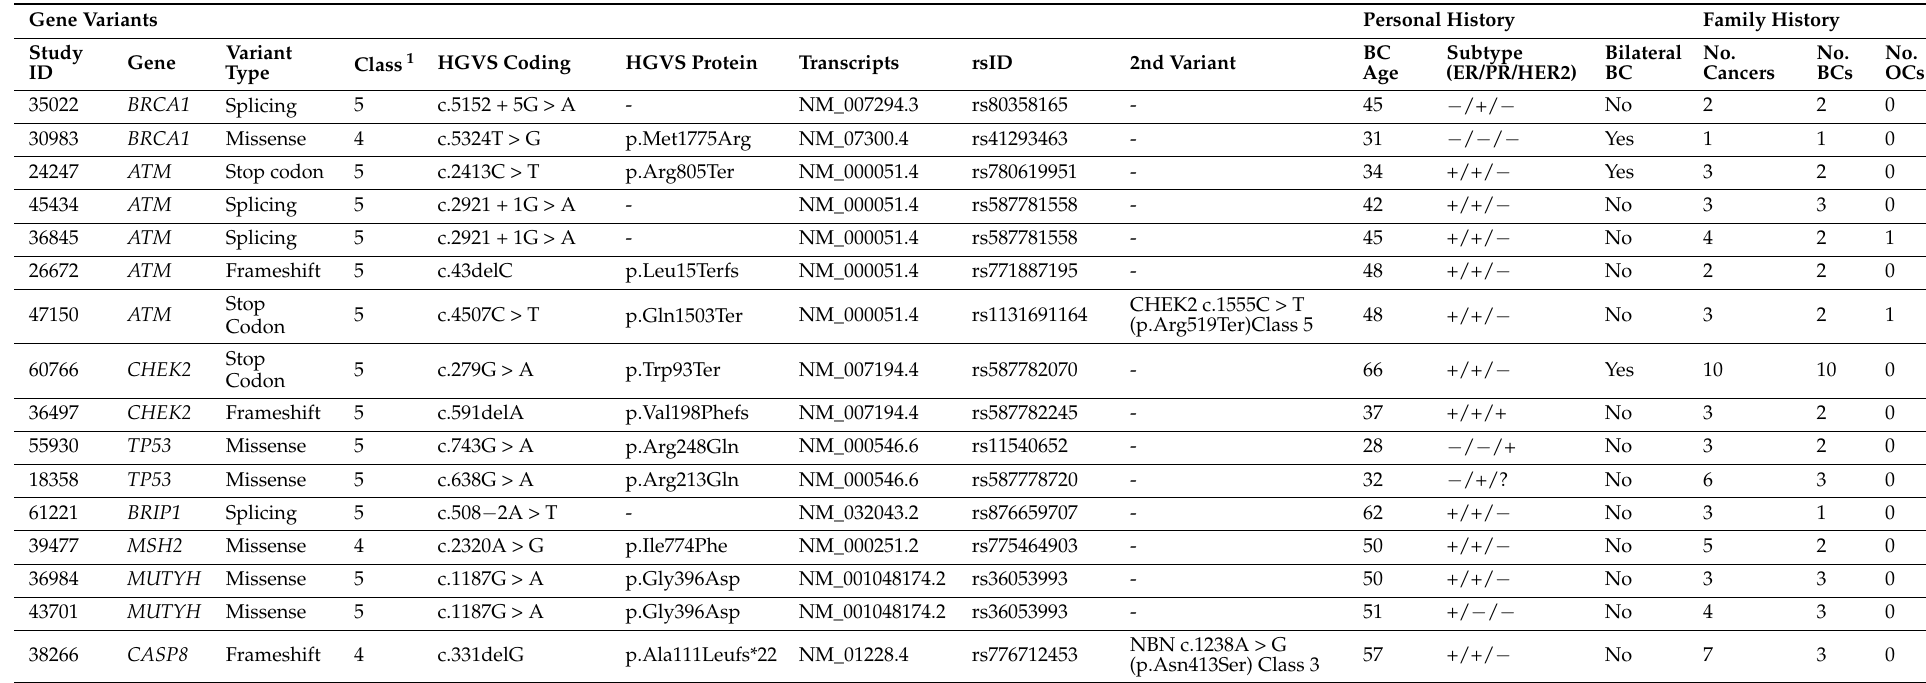
Table 2. Pathogenic variants in the study